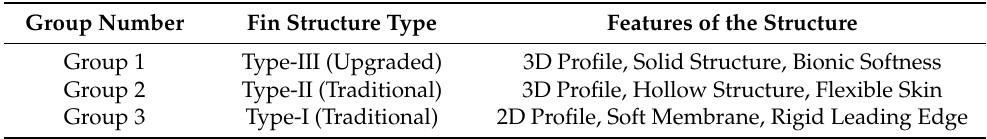
Table 2. Mapping Table of the Experiment Group Numbers and Fin Structure